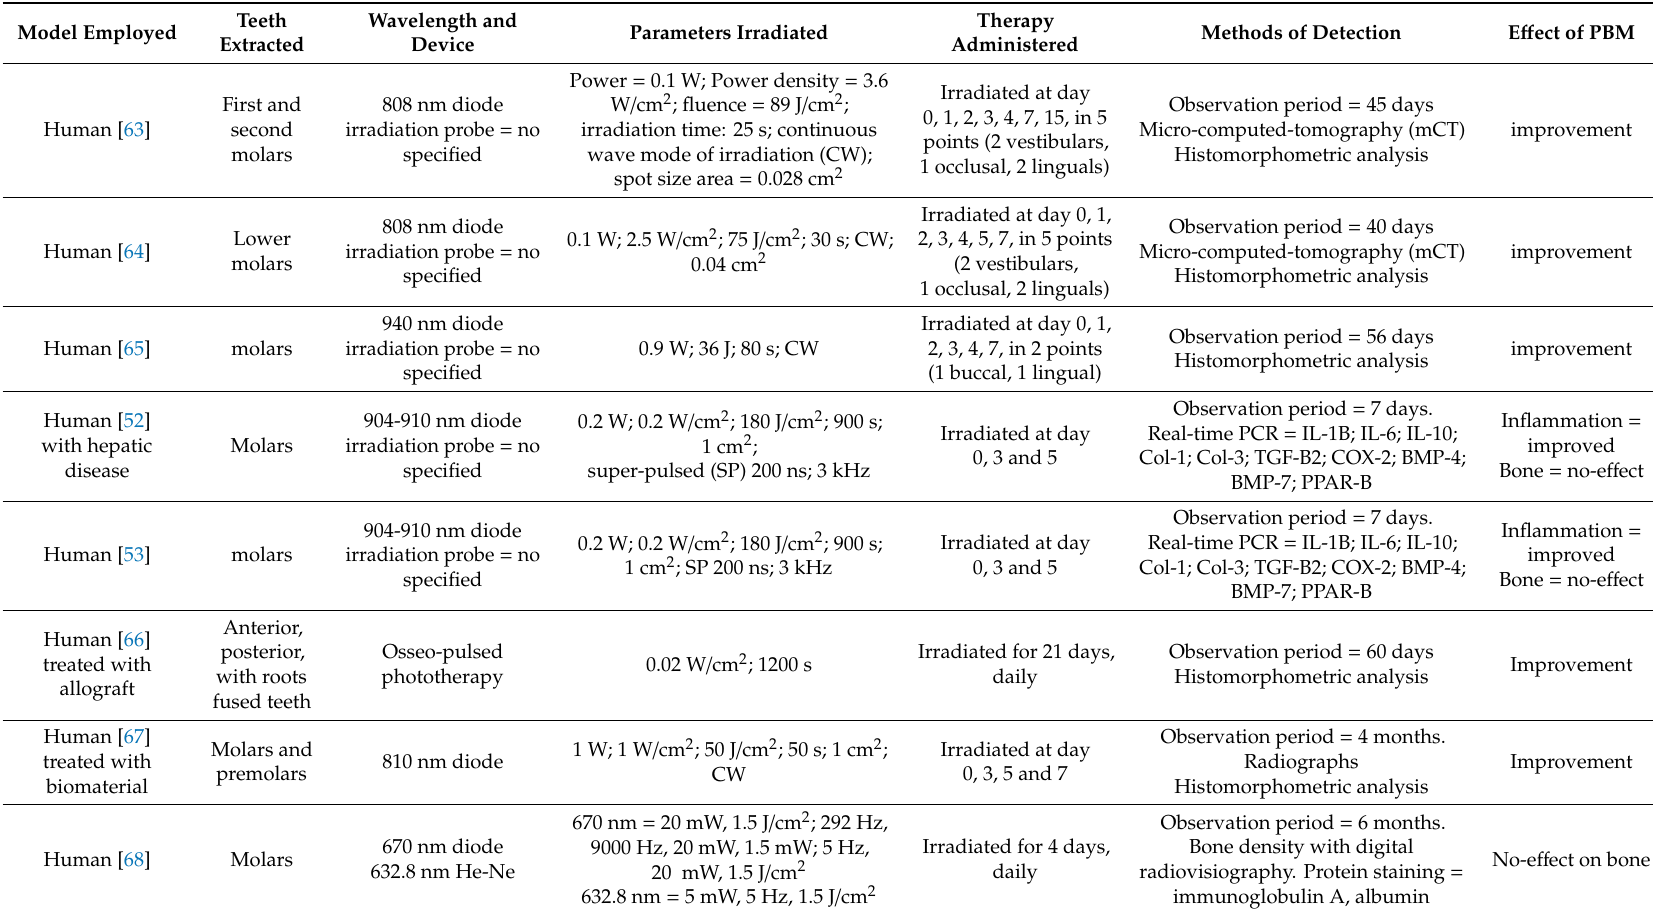
Table 2. Study on photobiomodulation (PBM) and socket preservation in human. A schematic representation of the experimental set-up and